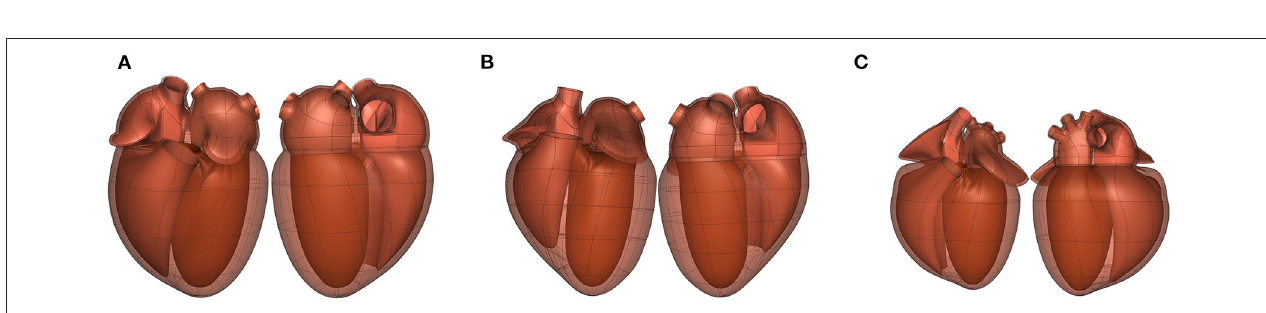
FIGURE 7 | Front (left) and back (right) views of the (A) human (dataset available from https://sparc.science/datasets/100), (B) pig (dataset available from https://sparc.science/datasets/102), and (C) rat (dataset available from https://sparc.science/datasets/99) scaffolds (not to scale). The topology of the scaffold is different for each species as each has a different number of pulmonary veins entering the left atrium (4, 2, and 3,